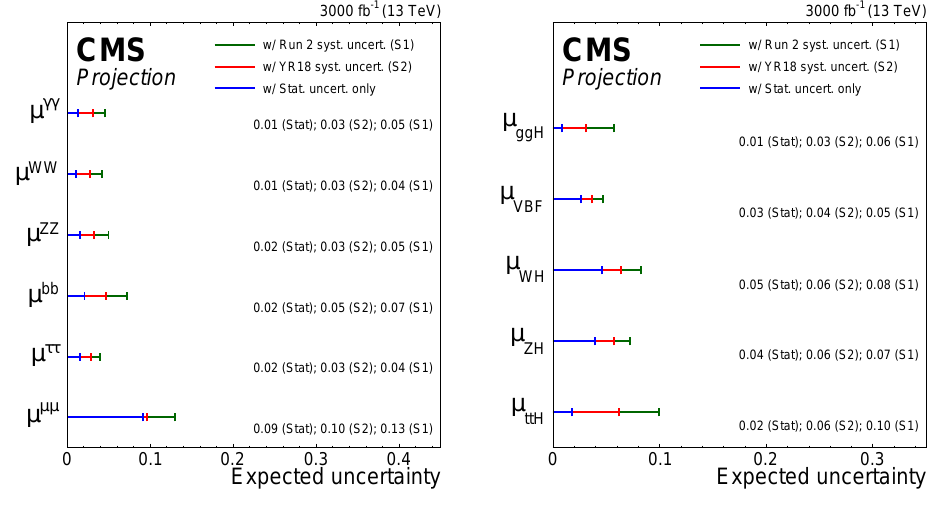
Figure 2: Projected CMS uncertainties from the HL-LHC on the Higgs cou- pling strength parameters for various channels (left) and production mechanisms (right) [ 7 ]